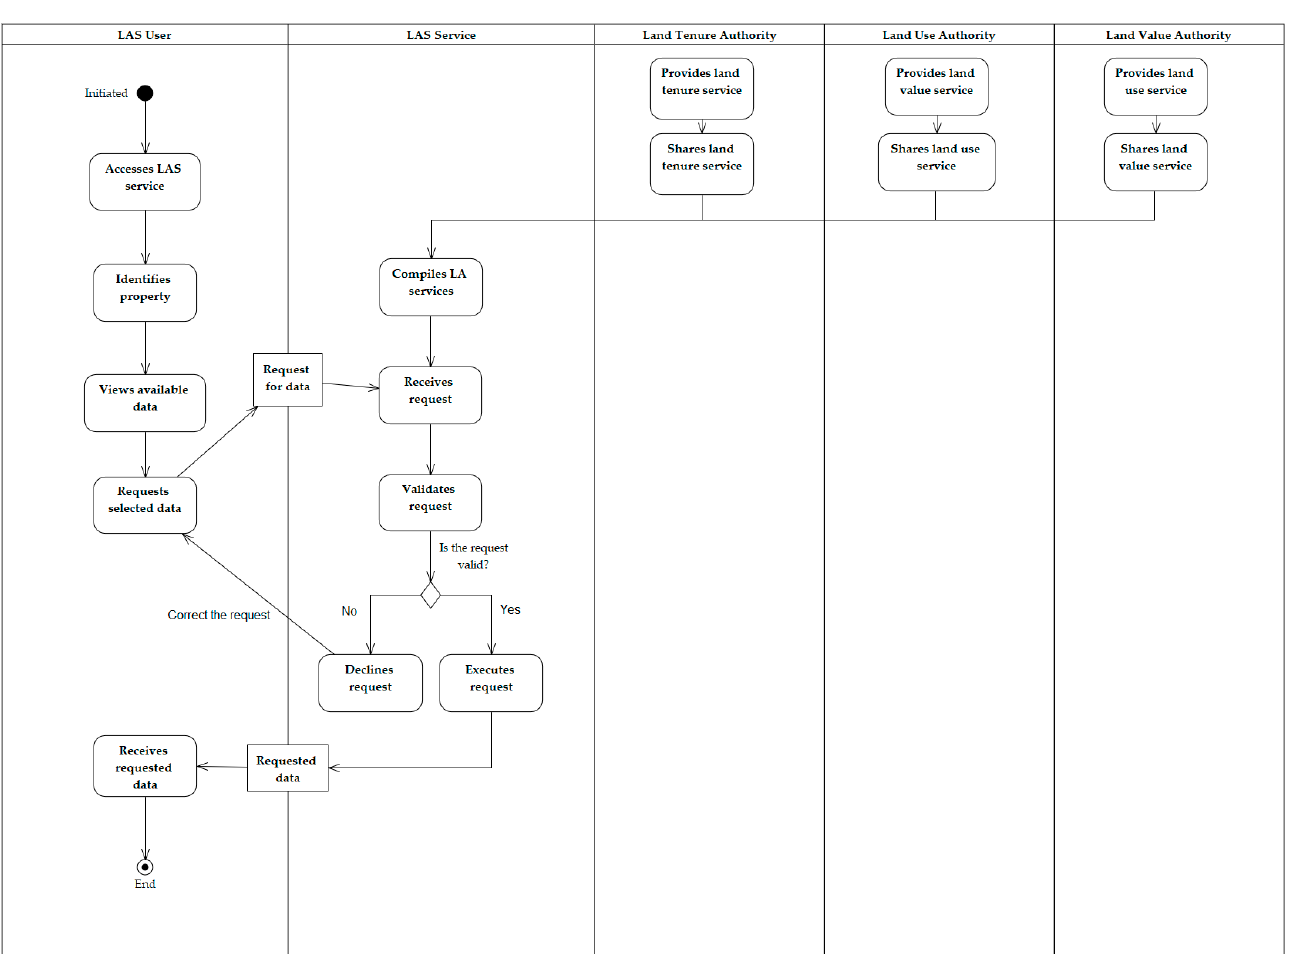
Figure 4. Improved state of the examined use case. Source: Own compilation.